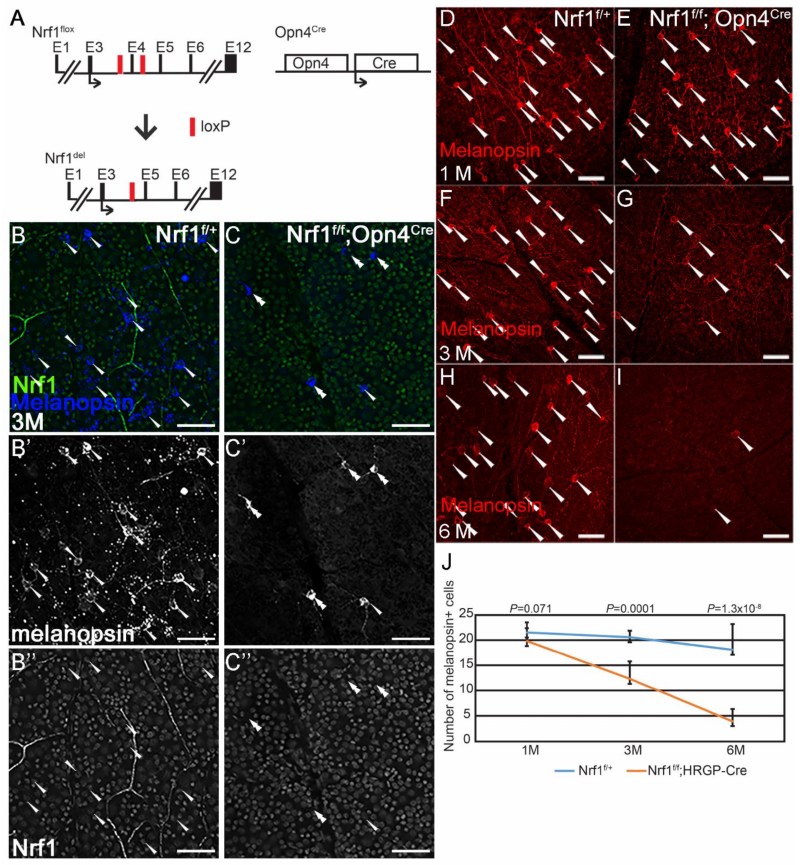
Figure 3. Nrf1 conditional deletion by Opn4 cre causes slow degeneration of ipRGCs. ( A ) Schematic representation of Nrf1 flox allele, Nrf1 -deleted allele, and Opn4 Cre allele. Exons are indicated as E1–E12. Black arrows indicate the translational start sites for Nrf1 and Cre protein. Red boxes indicate loxP sites. ( B , C ) Immunostaining of 3-month-old Nrf1 f/+ ( B ) and Nrf1 f/f ; Opn4 cre ( C ) retinal flat-mounts with anti-melanopsin ( B (cid:48) , C (cid:48) ) and anti-Nrf1 ( B (cid:48)(cid:48) , C (cid:48)(cid:48) ) antibodies. ( B , C ) merged images. Melanopsin + and Nrf1 + cells are indicated with arrowheads. Melanopsin + Nrf1 − cells are indicated with double arrowheads. ( D – I ) Immunostaining of Nrf1 f/+ ( D , F , H ) and Nrf1 f/f ; Opn4 cre ( E , G , I ) retinal flat-mounts with anti-melanopsin antibody. Melanopsin + cells are indicated with arrowhead. ( J ) Number of melanopsin + cells of Nrf1 f/+ and Nrf1 f/f ; Opn4 cre retinal flat-mounts at 1 month, 3 months, and 6 months old. Scale bars: 50 µ